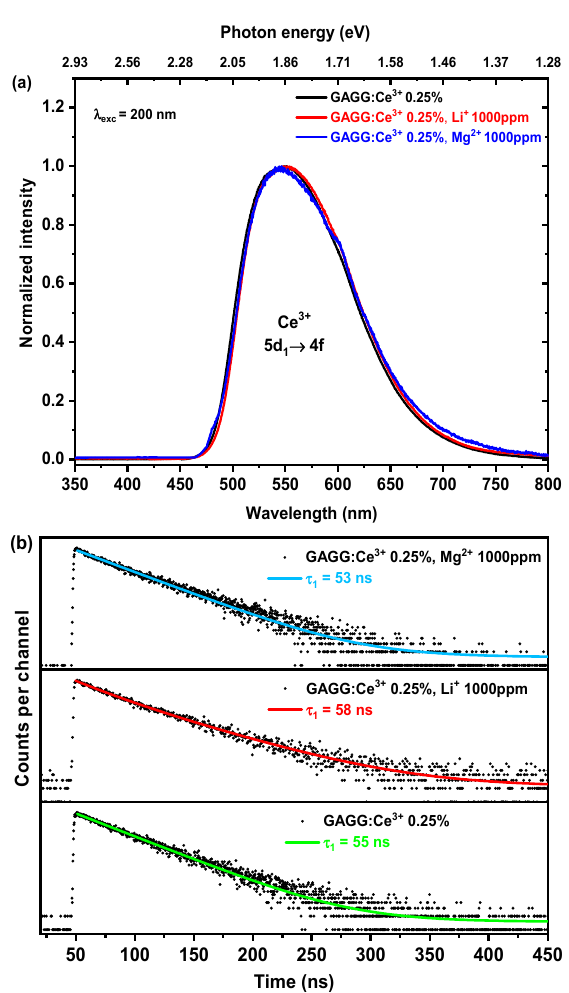
Figure 6. ( a ) Emission spectra excited with synchrotron radiation with an energy of 200 nm (6.20 eV); ( b ) photoluminescence decay kinetic curves for the Ce 3+ emission ( λ exc = 450 nm, λ emi = 540 nm) in Ce 3+ , Ce 3+ :Li + , and Ce 3+ :Mg 2+ doped GAGG single crystals, 300 K. The impact of the Mg 2+ and Li + co-dopants on Ce 3+ energy levels can be seen in the decay times of Ce 3+ emission; see Figure 6b. The single exponential function was used to fit the experimental data according to Equation (1):